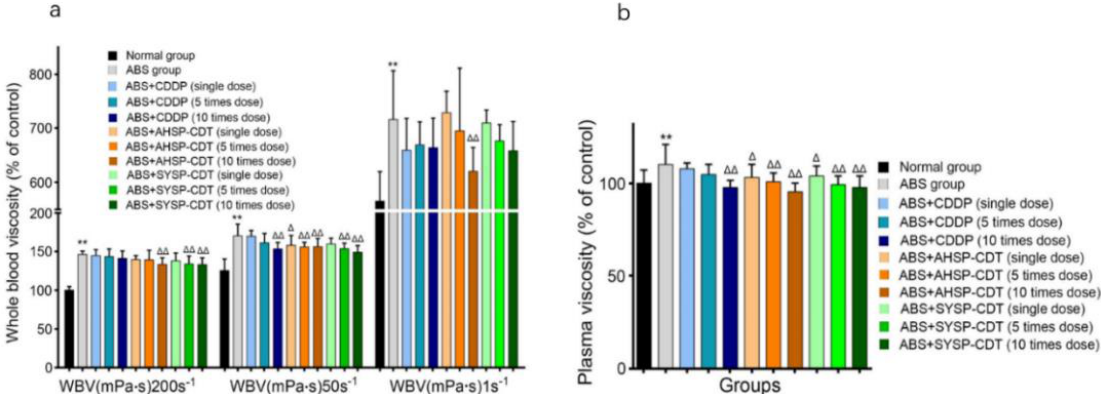
Figure 11. Bar chart of Danshen preparations’ effect on whole blood viscosity (WBV) ( a ) and plasma viscosity (PV) ( b ) of acute blood stasis rats. Compared with the normal group, * p < 0.05, ** p < 0.01; Compared with the acute blood stasis (ABS) group, Δ p < 0.05, ΔΔ p < 0.01.